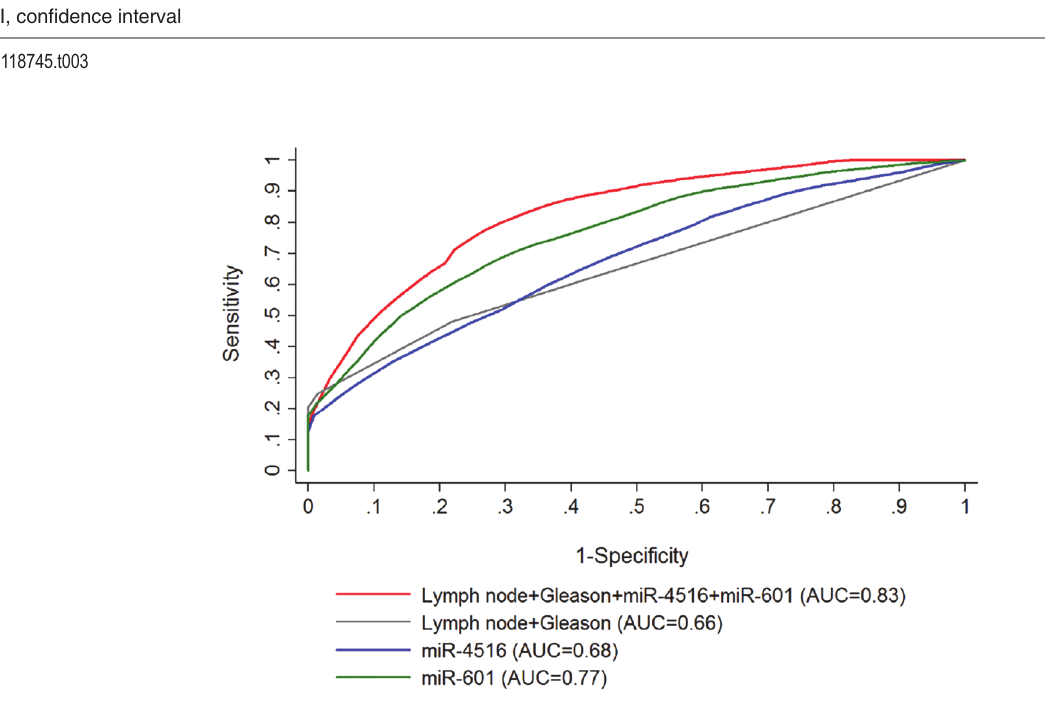
Fig 3. Area under the receiver operating characteristic curve (AUC) of miRNA-based predictive salvage RT model. AUC curves were generated using a stepwise Cox regression model to determine a signature predictive of biochemical recurrence post-salvage radiation therapy. Gleason score, lymph node status, hsa-miR-4516, and hsa-miR-601 (red) performs the best with an AUC of 0.83 followed by a model containing hsa-miR-601-alone (green) (AUC = 0.77), hsa-miR-4516-alone (blue) (AUC = 0.68), and lastly, Gleason score and lymph node status (grey) (AUC = 0.66).